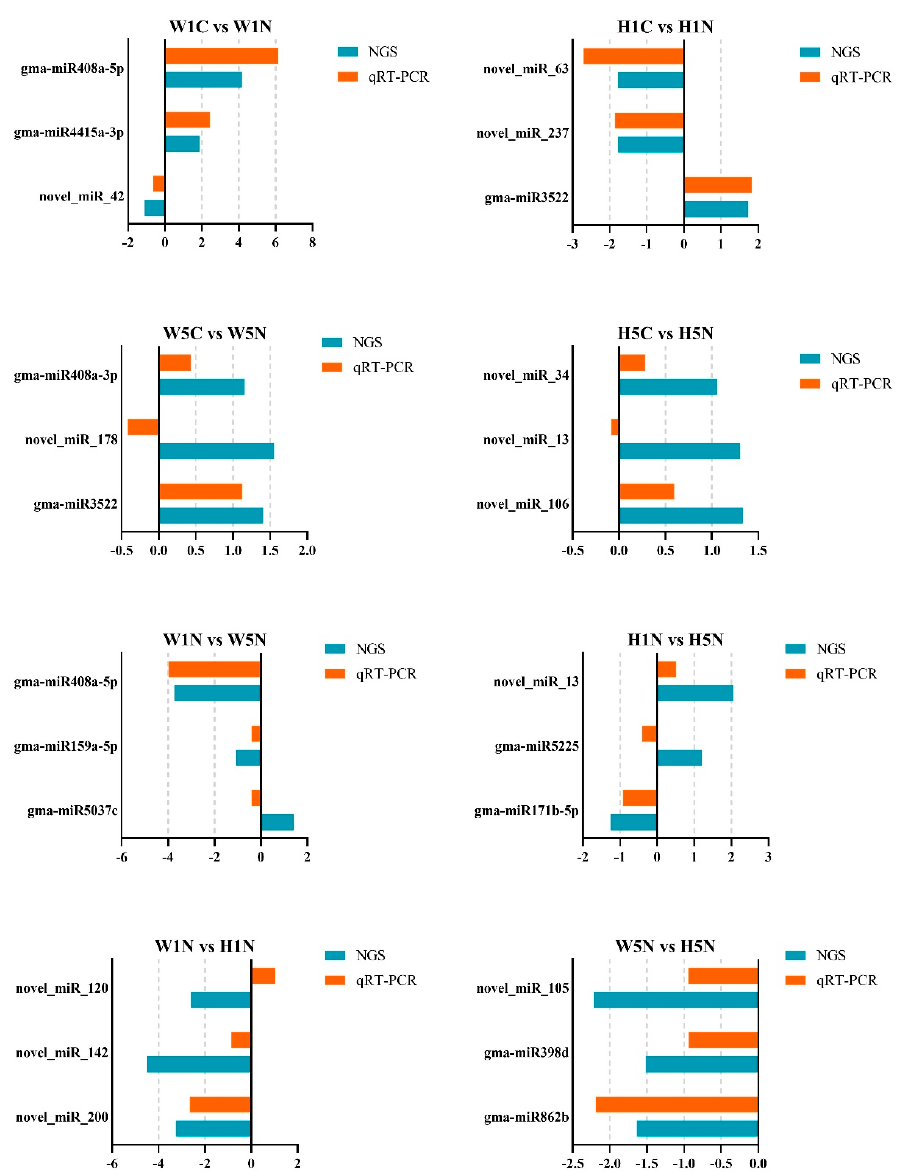
Figure 5. qRT-PCR validates the expression pattern of selected miRNAs in high-throughput sequencing. Three miRNAs in each comparison were randomly selected for qRT-PCR validation, X axis stands for relative expression of miRNAs, NGS, the expression pattern of miRNAs obtained in high-throughput sequencing, qRT-PCR, and the miRNA expression pattern of miRNAs validated by qRT-PCR.